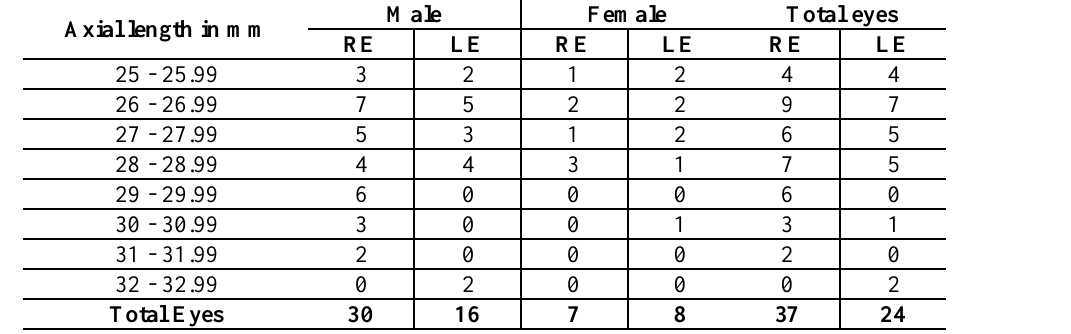
Table III : Presence of Lattice According to the Gender Distribution Male Female